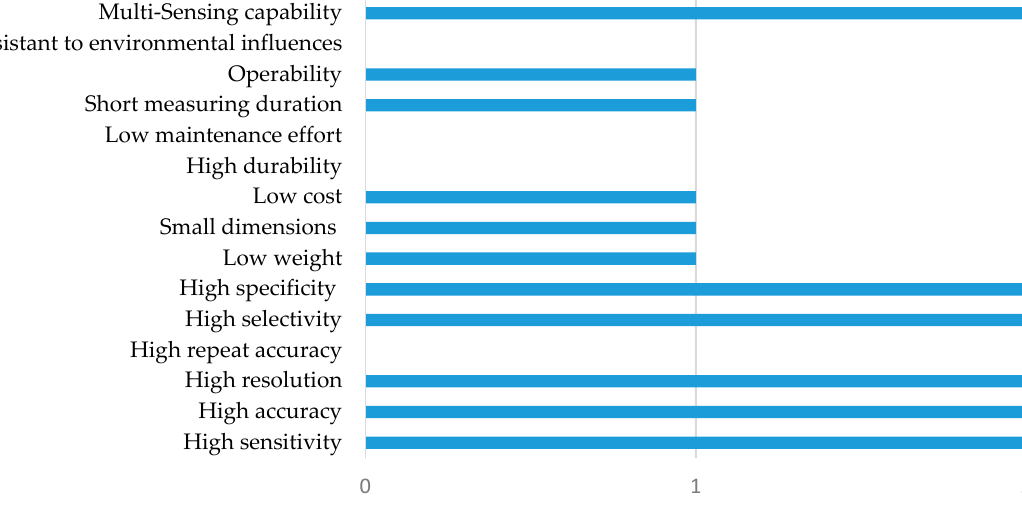
Figure 2. Performance profile of biosensors for odor detection in comparison to competitive technical odor sensors, based on Table 1; fields: 0 = is fulfilled worse by comparison; 1 = is fulfilled equally well or no clear statement to be made; 2 = is fulfilled comparatively